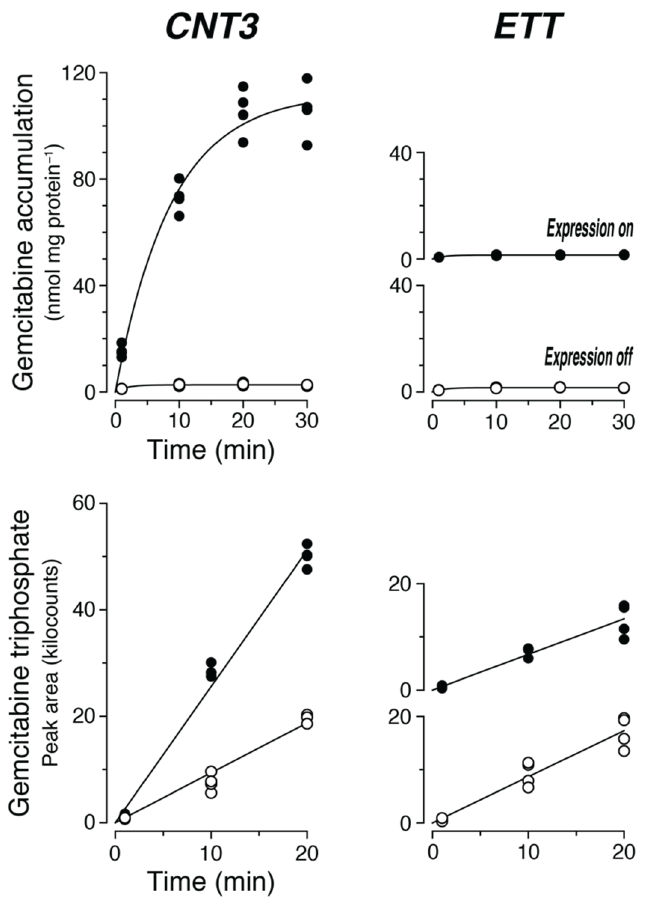
Figure 3. CNT3 catalyzes the uptake of gemcitabine into 293 cells and thus stimulates the generation of gemcitabine triphosphate; ETT does neither. Each circle represents a dish ( n = 4). Time course of gemcitabine accumulation ( Upper row ). Cells without (open circles) or with transporter expression (filled circles) were incubated for the indicated times at 37 ◦ C with 100 µ M gemcitabine plus 100 nM NBMPR in uptake buffer. See legend in Figure 1 for further details. In the same lysates, gemcitabine triphosphate was measured by LC–MS/MS ( Lower row ). The peak area is proportional to analyte content. Calibration was not possible since we had no pure